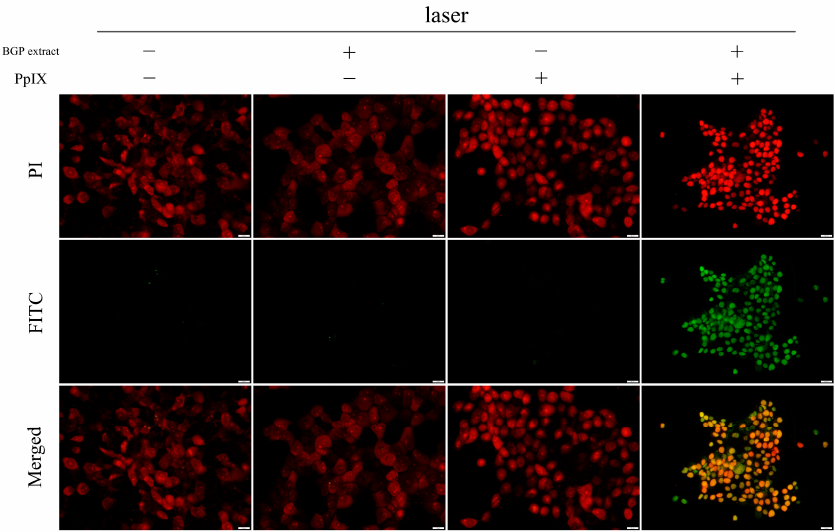
Figure 3. Apoptotic detection by TUNEL assay. PI (red) stained the nucleus while FITC (green) labeled the apoptotic cells. Images were captured by a confocal scanning laser microscope. Scale bar: 50 μ m.